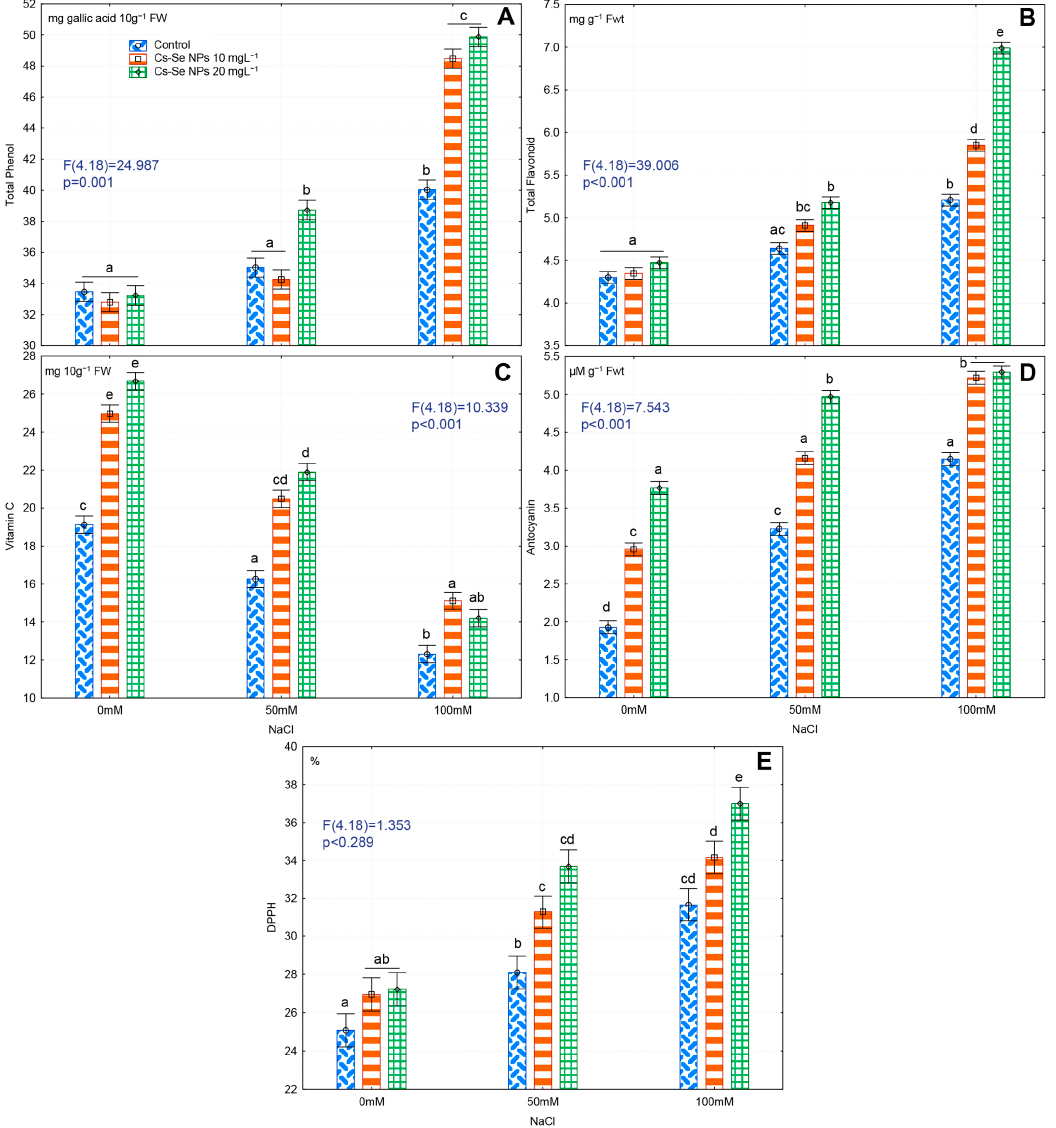
Figure 5. Effect of increasing concentration of Cs–Se NPs on total phenol ( A ), total flavonoids ( B ), vitamin C ( C ), anthocyanin ( D ), and antioxidant activity (DPPH) ( E ) on bitter melon ( Momordica charantia ) fruit under salinity stress. The SDs denoted by lower-case letters in the same treatment indicate significant differences at p < 0.05 by Tukey’s post hoc test. Growth under saline conditions significantly decreased vitamin C content in bitter melon fruit. As observed in this study, salinity decreases photosynthesis in plant.